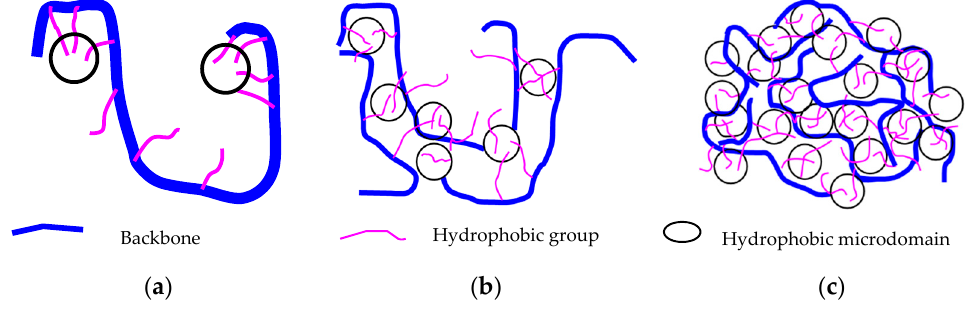
Figure 2. Schematic diagram of HAWP association ( C : concentration; C *: critical concentration): ( a ) C < C *, intramolecular association; ( b ) C < C *, intermolecular association; and ( c ) C > C *, the formation of a network structure by the association of molecules.